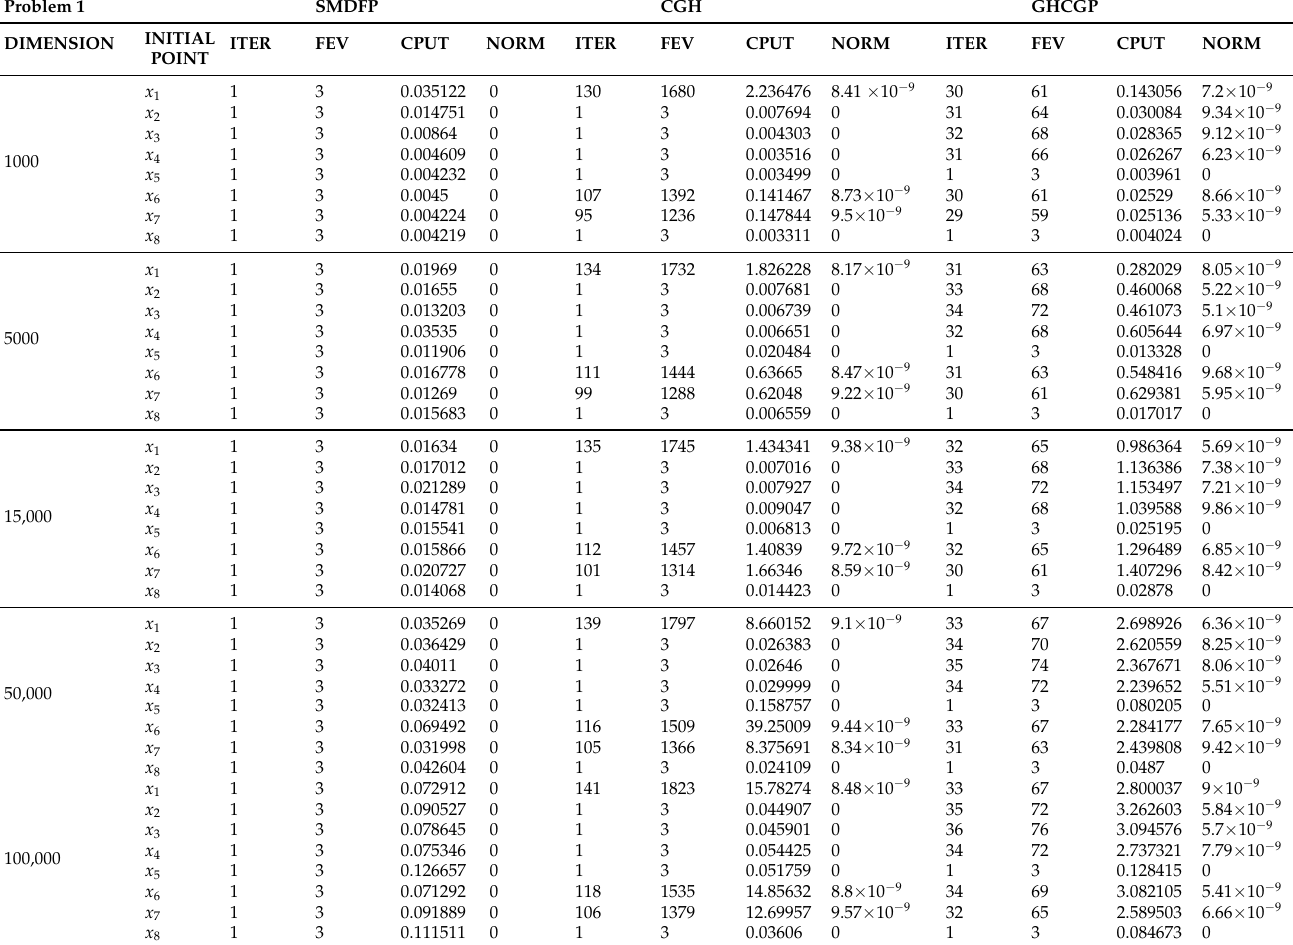
Table 1. Numerical comparison of the SMDFP, CGH [61], and GHCGP [62]